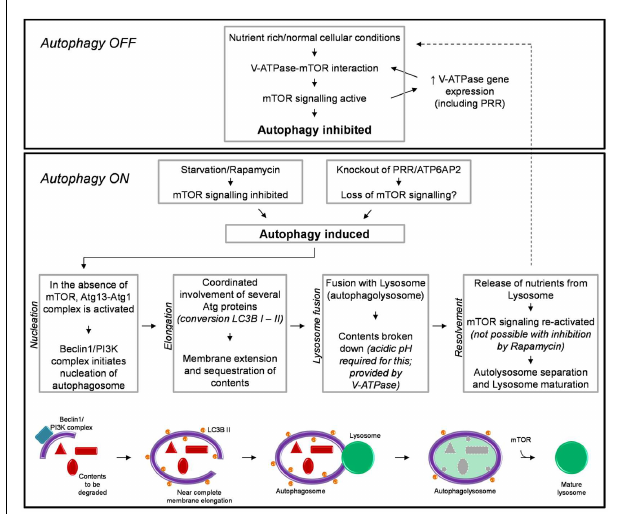
FIGURE 1 |A brief schematic of the regulatory processes involved in autophagy (see text for detail) . Also shown is our hypothesized mechanism by which knockout of PRR/ATP6AP2 results in a loss of mTOR activity and the induction of